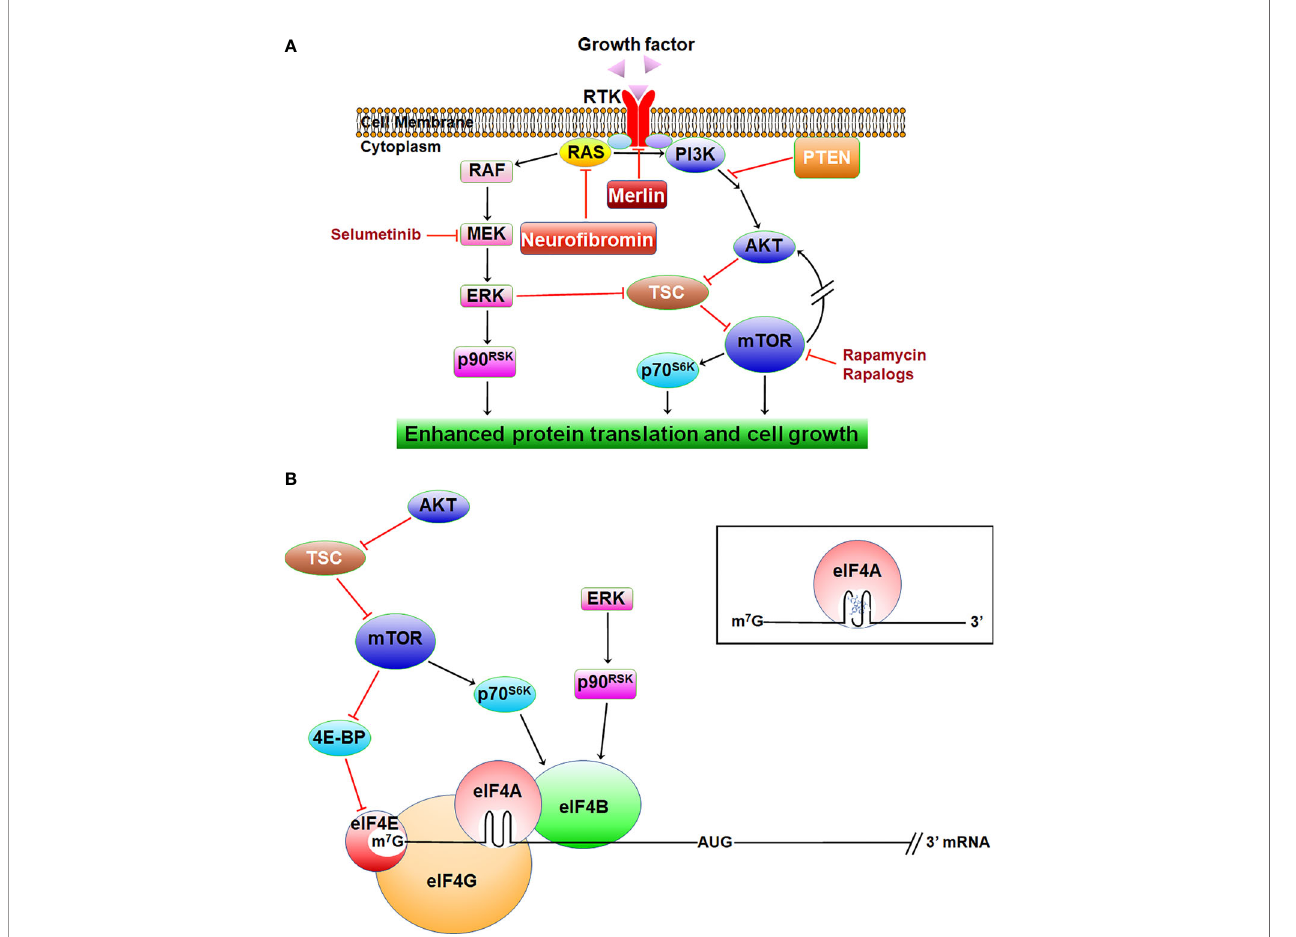
FIGURE 1 | The signaling pathways inhibited by neuro fi bromin and merlin. (A) NF-related tumors exhibit activated Ras/RAF/MEK/ERK and PI3K/AKT/mTOR, leading to enhanced protein translation and growth. (B) Activated ERK and AKT/mTOR enhance translation via eIF4B, which stimulates eIF4A activity. AKT/mTOR also promotes translation via eIF4E. Inset: rocaglamide locks eIF4A onto the structured 5 ’ -UTR of